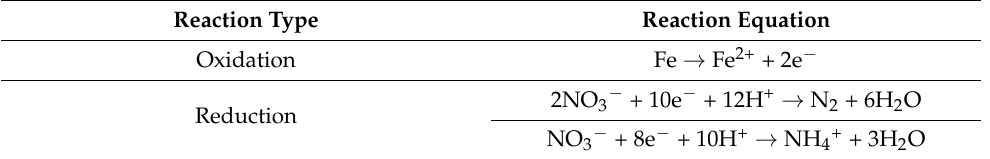
Table 1. Reactions of MIC bioelectrochemical mechanisms of B. licheniformis and B. cereus